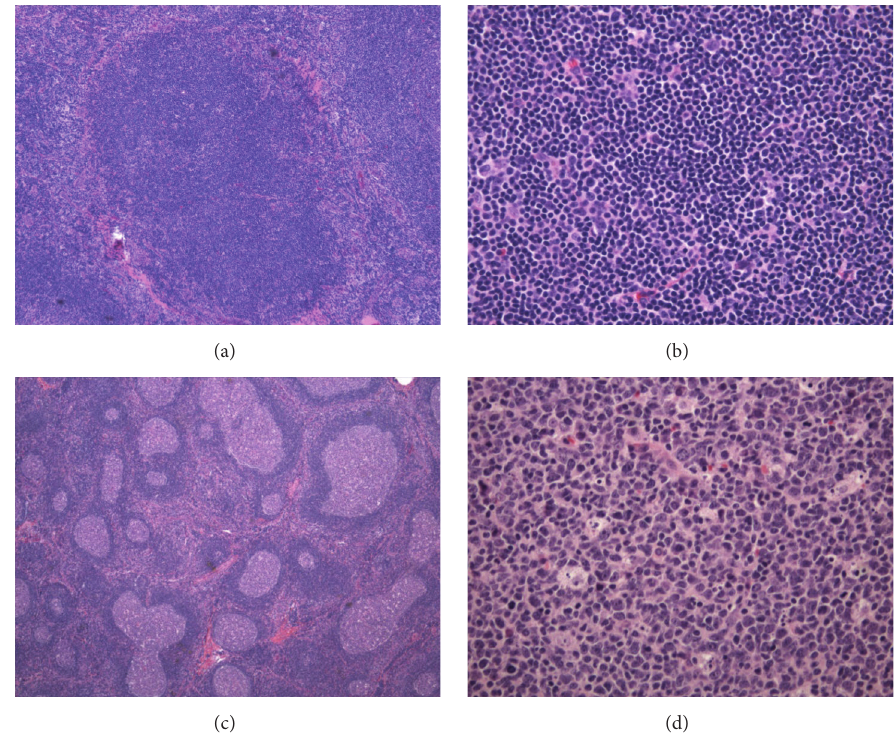
Figure 2: PTGC microscopic examination. (a) PTGC, markedly enlarged lymphoid follicle infiltrated by small mature mantle zone lymphocytes with gradual replacement of germinal center (H&E, 4x). (b) Background of florid follicular lymphoid hyperplasia (H&E, 2x). (c) PTGC, germinal center replaced by small mature mantle zone lymphocytes (H&E, 20x). (d) Reactive germinal center with numerous tingle body macrophages (H&E,